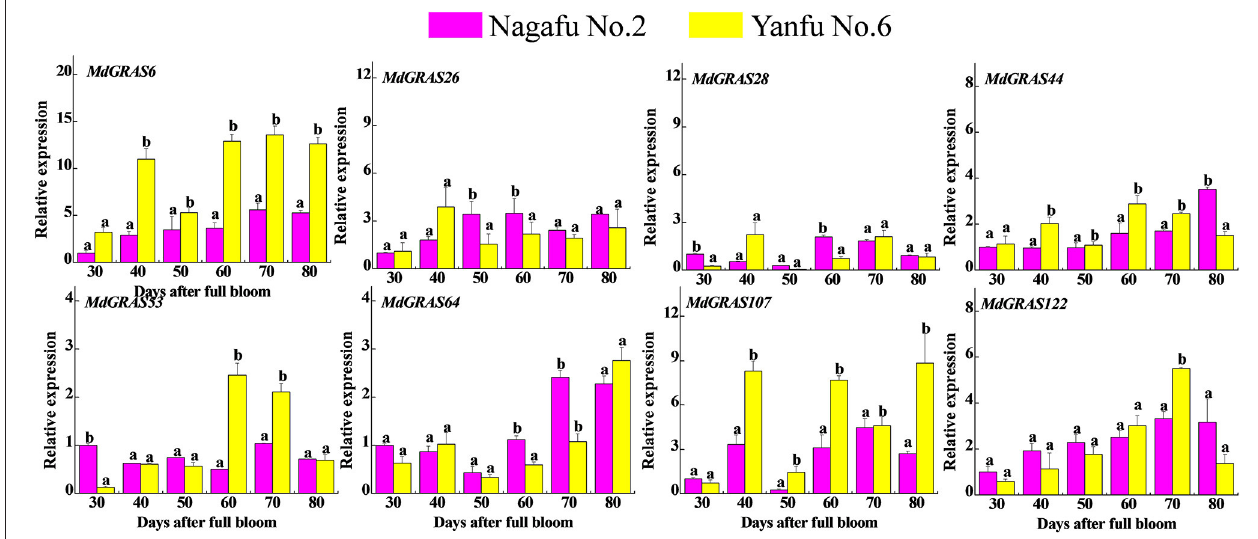
FIGURE 7 | Expression of candidate MdGRAS genes in apple buds in the easy-flowering variety “Yanfu No. 6” and different-flowering “Nagafu No. 2.” Samples were collected at 30, 40, 50, 60, 70, and 80 days after full bloom (DAFB). Each value represents the mean ± standard error of three replicates. Means followed by small letters (a, b) are significantly different at a level of